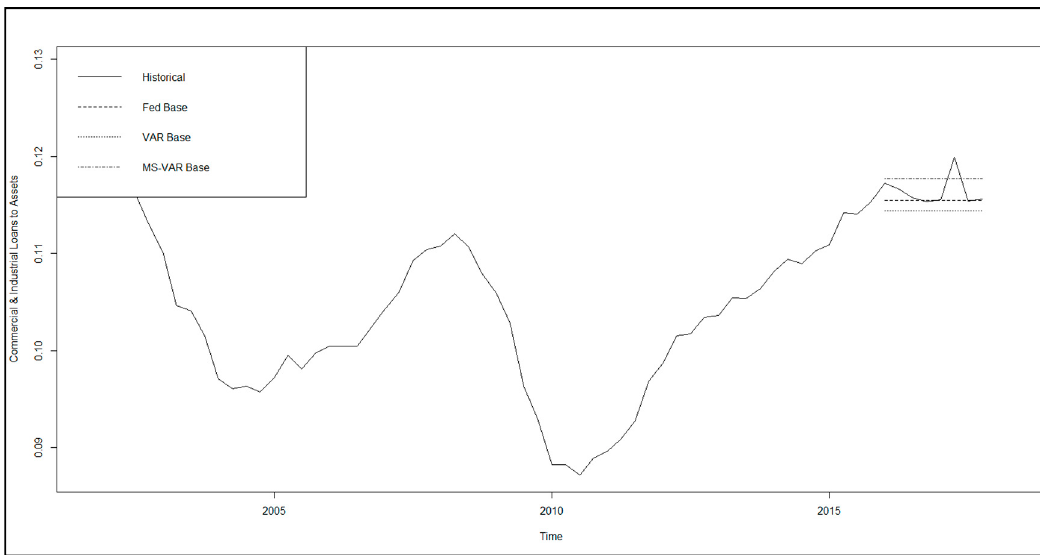
Figure 6. Time series and base scenarios—commercial and industrial loans to total assets (Federal Deposit Insurance Corporation (FDIC) Statistics on Depository Institutions (SDI) Report, Federal Reserve Board 4Q91–4Q15 and Jacobs (2018) models).